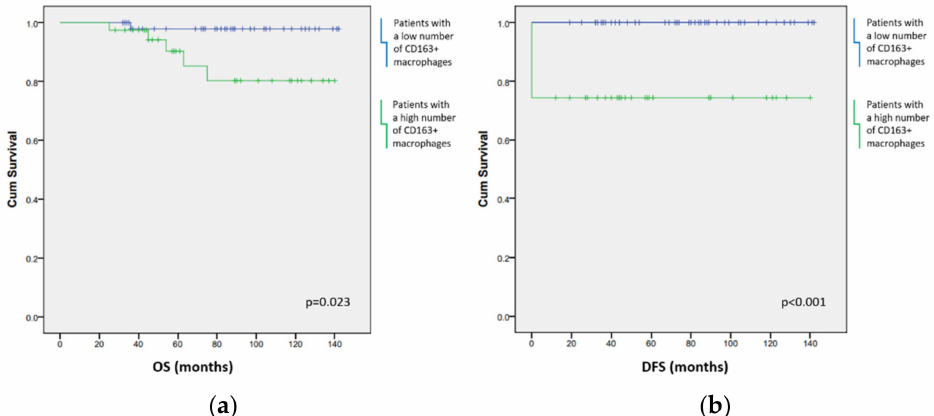
Figure 6. ( a ) A higher number of CD163+ cells contributed to poorer overall survival (OS) of the patients. ( b ) Patients who had a higher number of CD163+ cells also had worse disease-free survival (DFS). Blue line: patients with a lower number of CD163+ macrophages infiltrating tumor tissue; green line: patients with a higher number of CD163+ macrophages infiltrating tumor tissue. DFS of the patients was also affected by the presence of three or more copies of TP53 ( p = 0.004) (Figure 7). EBV infection did not affect the length of the patients’ survival nor the outcome of the